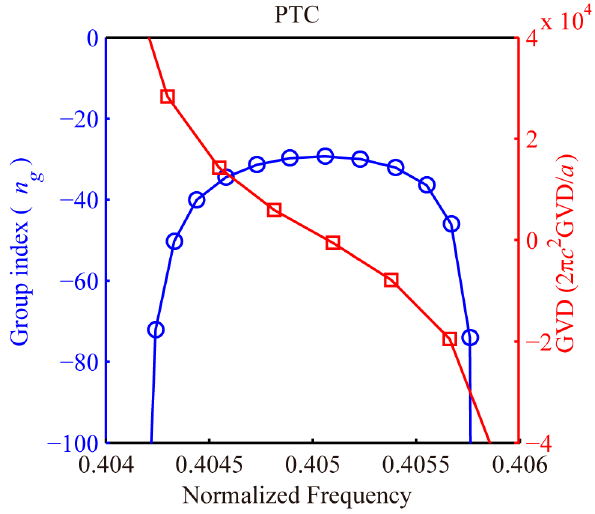
Figure 8. Variations of the group velocity and GVD with the frequency for the surface optical waves (SOW) band marked with yellow color in Figure 7b. Blue and red lines denote the group index and the GVD, respectively.